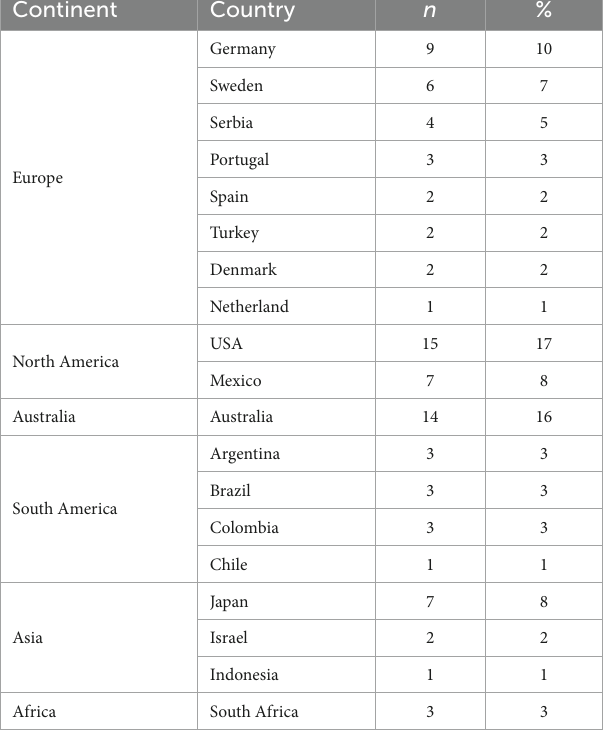
TABLE 3 All authors’ countries of affiliations.